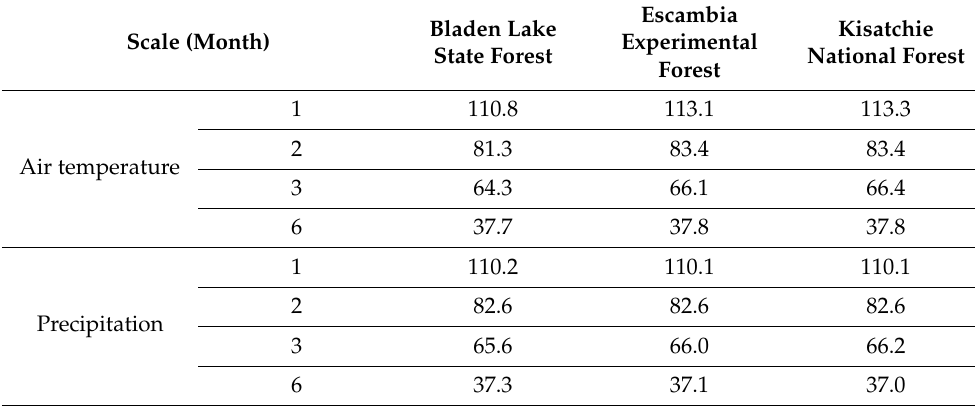
Figure 5. The entropy dynamics of air temperature at multi-year at the three sites. Table 2. The entropy at the monthly scale for air temperature and precipitation from 1901 to 2020.